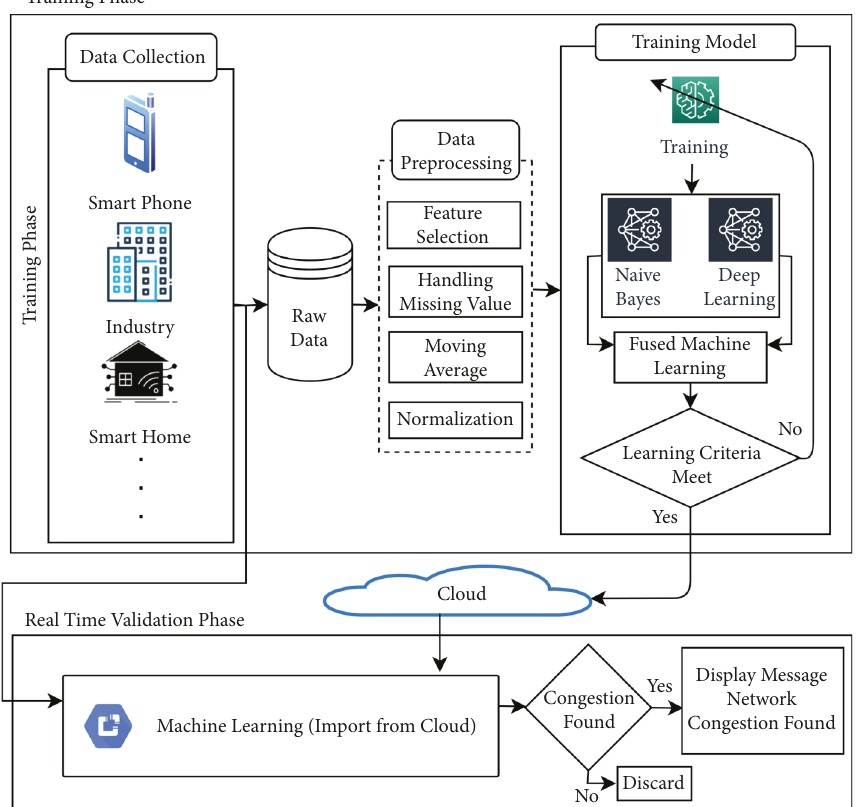
Figure 1: Proposed model of smart congestion control in 5G/6G networks using hybrid deep learning